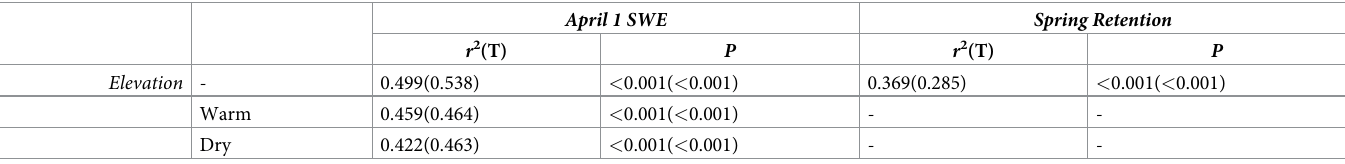
Table 4. Regression and Kendall correlation matrix values for elevation at the watershed scale. Elevation - Warm Dry 0.422(0.463) < 0.001( < 0.001) - - Correlation with April 1 SWE and/or spring retention are shown (N = 121). The regression coefficient r 2 and Kendall tau (T) are shown outside and inside parentheses